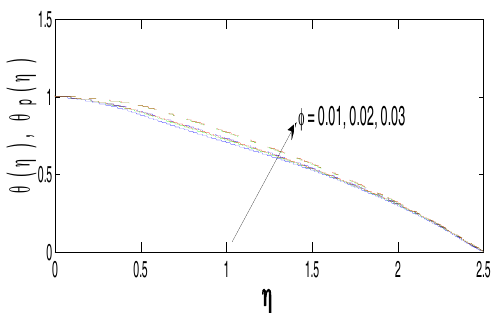
Figure 12. Impact of φ on temperature profile θ and θ p of fluid with dusty particles.